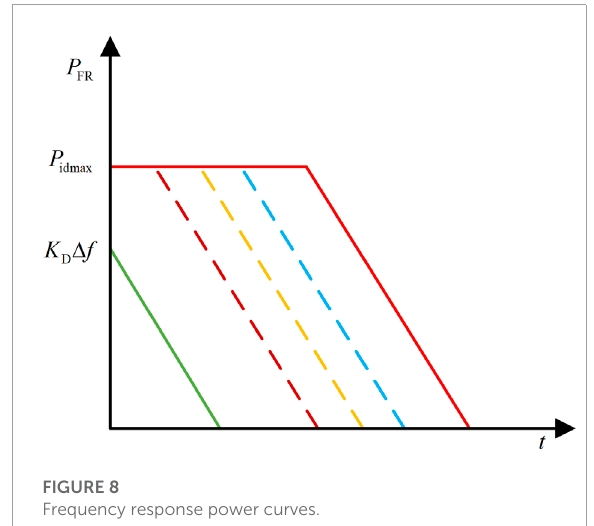
FIGURE 8 Frequency response power